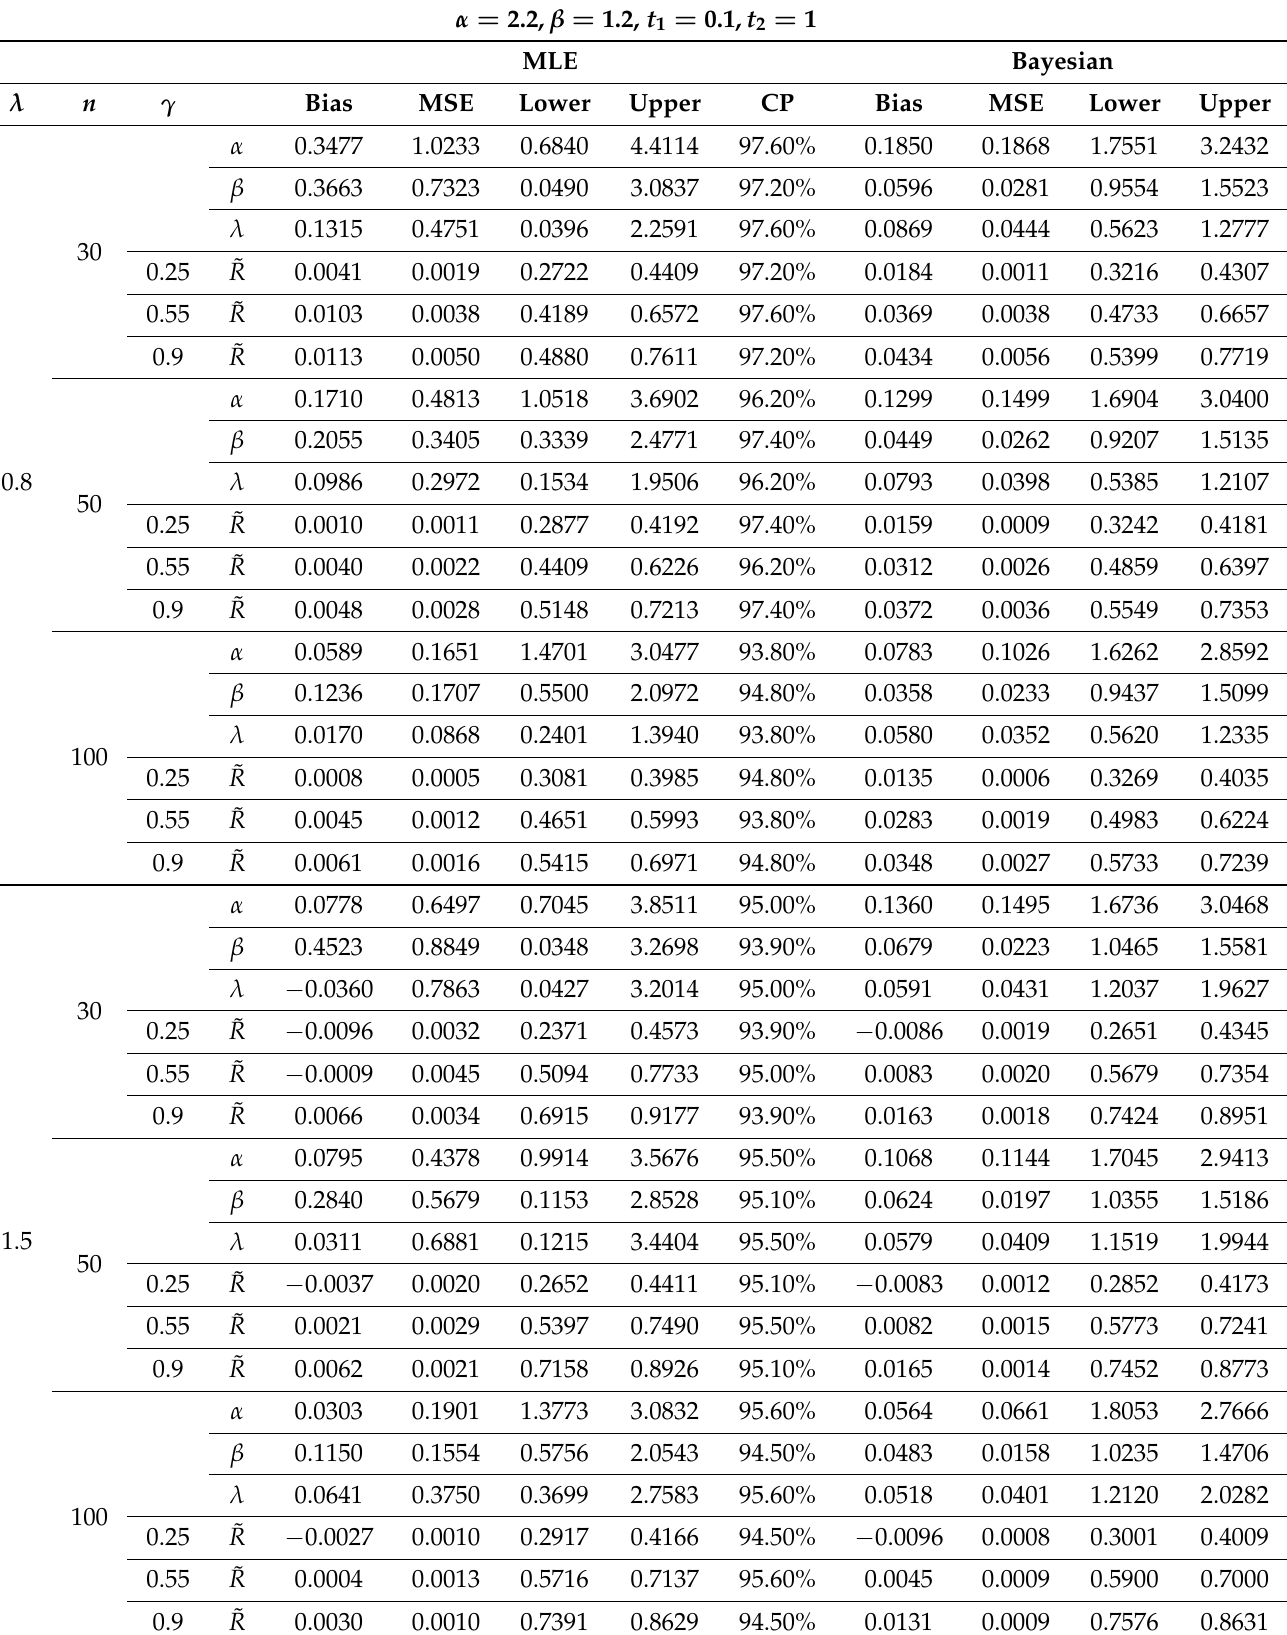
Table 2. Bias, MSE, and CI for fuzzy reliability and parameters of the model in case